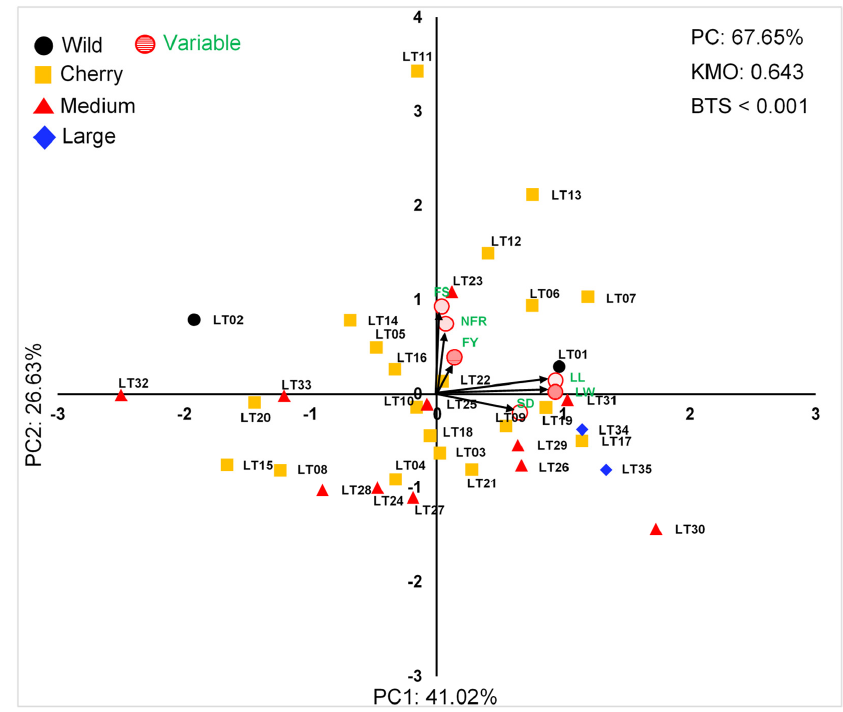
Figure 5. Biplot for the first two principal components (PC1 and PC2) was shown using the principal component analysis (PCA) with 6 physiological traits and 35 tomato accessions depending on fruit types including wild (black round circle), cherry (yellow square), medium (red triangle), and large (blue diamond) fruits under LT condition. The red round circle with horizontal lines and the arrow indicate the variables and the direction of vectors, respectively. Leaf width (LW), leaf length (LL), stem diameter (SD), number of fruits (NFR), fruit setting (FS), and fruit yield (FY).